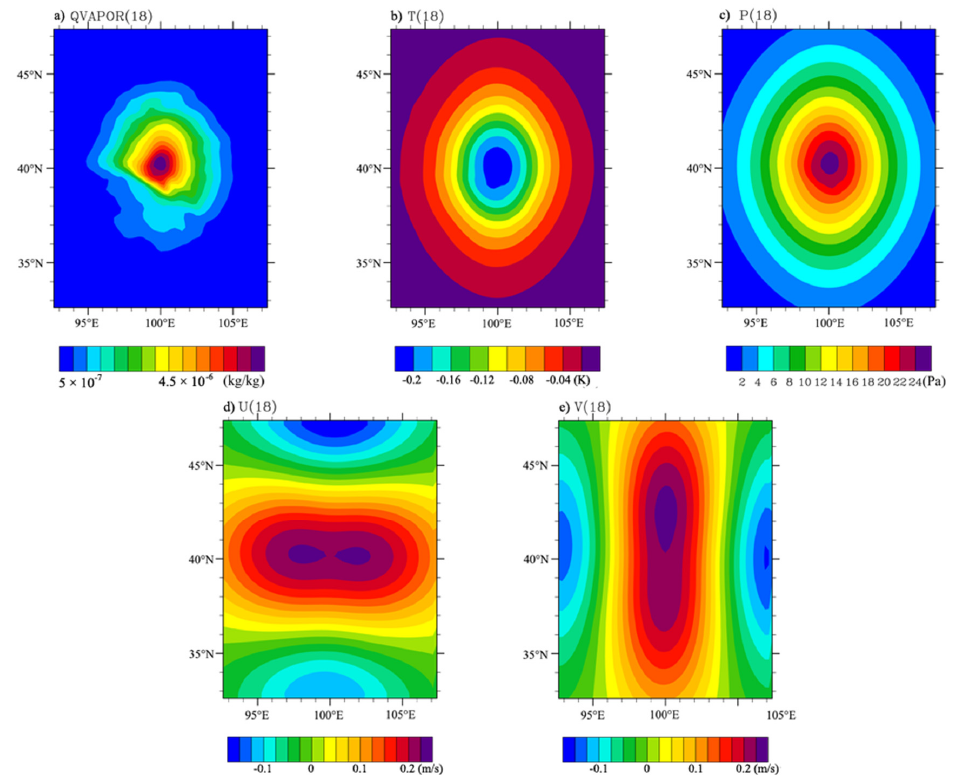
Figure 4. Assimilation tests of single observations of control variables at a central point: ( a ) vapor observations; ( b ) temperature observations; ( c ) pressure observations; ( d ) U observations; and ( e ) V observations. Remote Sens. 2017 , 9 , 963